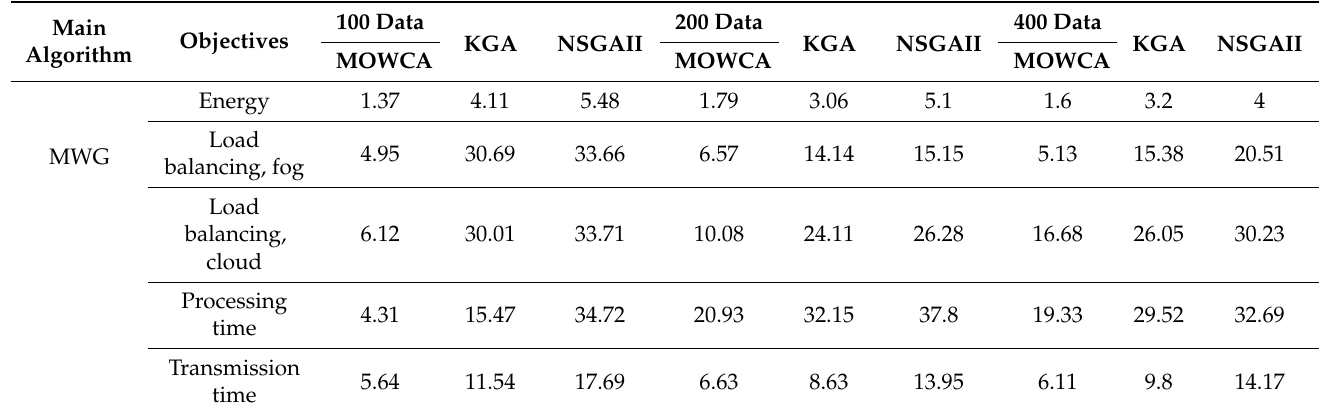
Table 7. Comparison of algorithms’ best solution based on